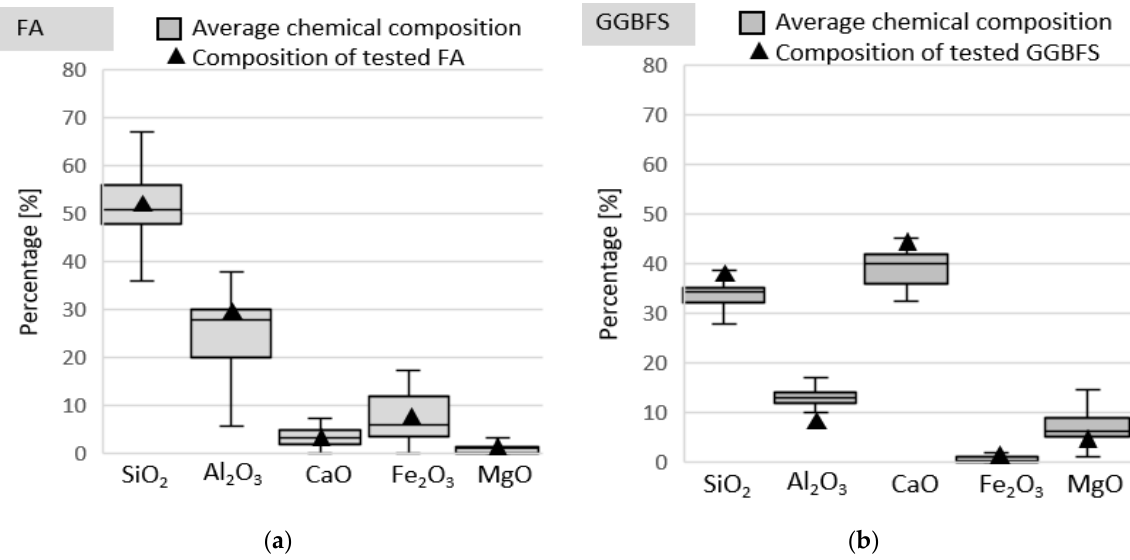
Figure 1. Comparison between the oxide compositions of tested precursors and the average values derived from reviewed studies: ( a ) fly ash and ( b ) ground granulated blast-furnace slag.